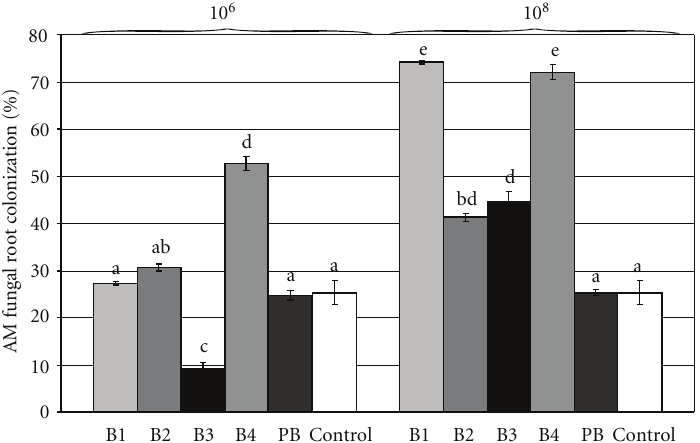
Figure 4: Percentage of AM fungal root colonization at harvest (15 weeks) in triplicate root samples with di ff erent inoculates of paenibacilli strains (B1–B4 and PB177) and Glomus mosseae . Two inoculation doses of 10 6 and 10 8 bacterial cells 10 g − 1 of seeds were applied. The control was only inoculated with G. mosseae . The same letters above the bars indicate treatments without significant di ff erences ( P > . 05). Error bars represent the standard error of the